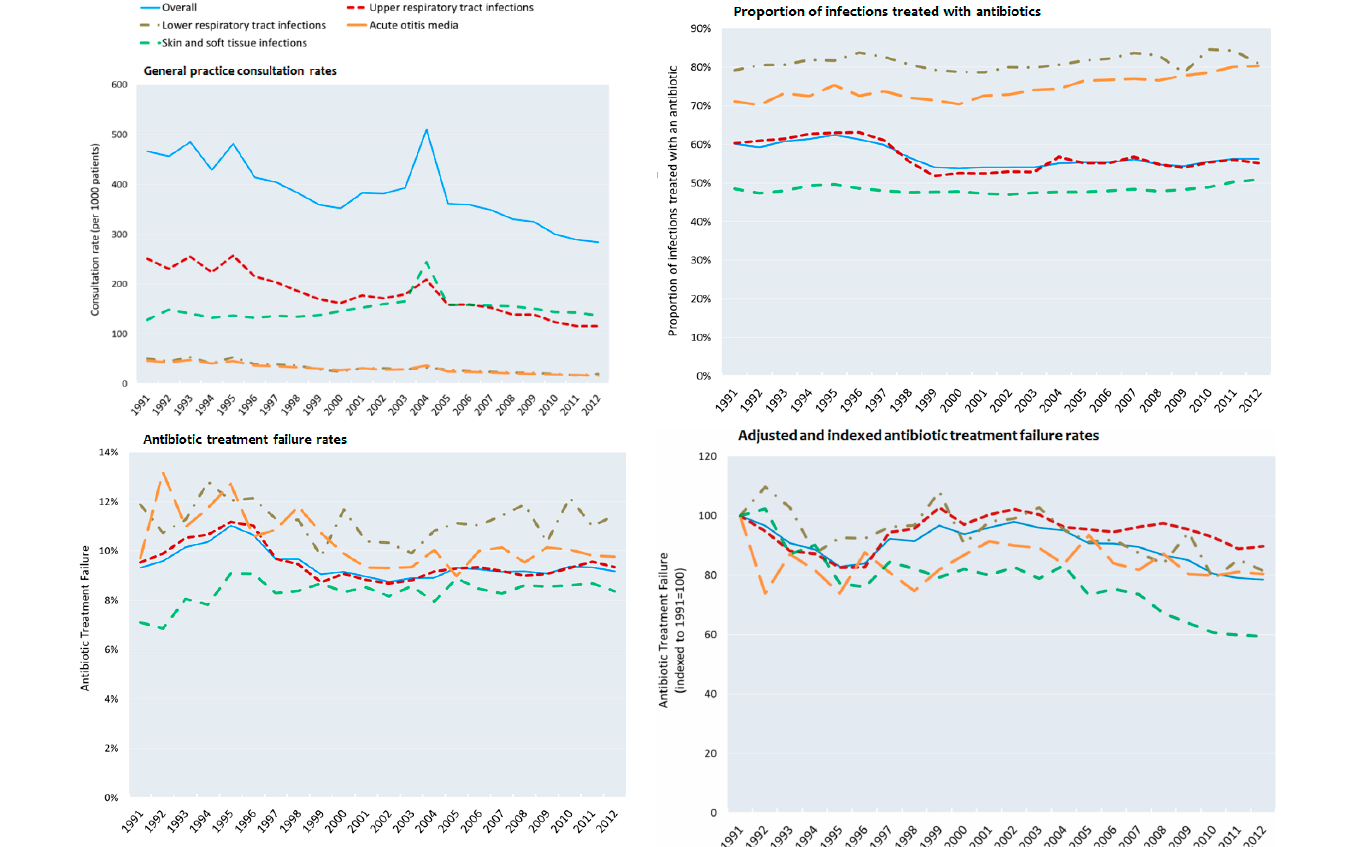
Figure 2. Consultation rates for the selected infection classes, proportion of infections in the selected classes treated with an antibiotic, antibiotic treatment non-response rates by infection class, and adjusted and indexed treatment non-response rates (indexed to 1991 = 100, and adjusted for age, sex, and type of antibiotic treatment used) observed between 1991 and 2012.